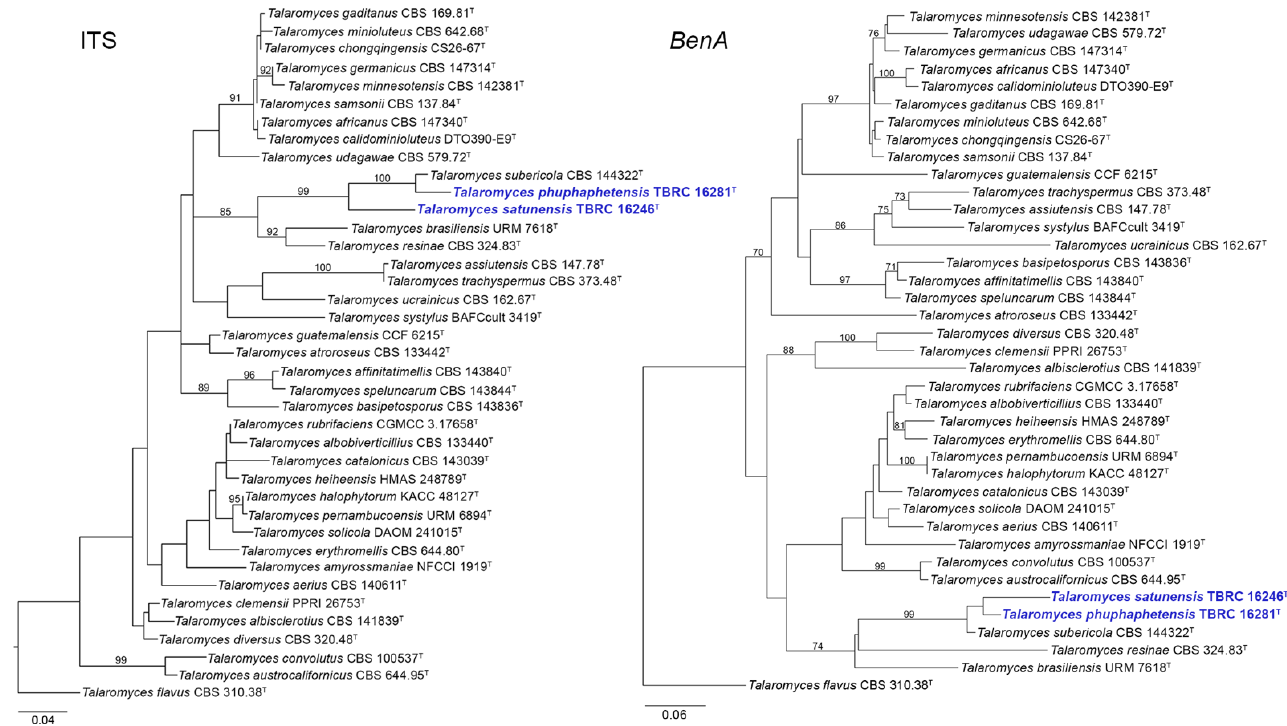
Figure 1. Maximum likelihood phylogeny based on the ITS region ( left ) and the BenA gene ( right ) for the closely related species belonging to Talaromyces section Trachyspermi . Talaromyces flavus (CBS 310.38) was chosen as the outgroup. New species are indicated in blue. T = Ex-type strain. Bootstrap (BS) values ≥ 70% are indicate d at the nodes.